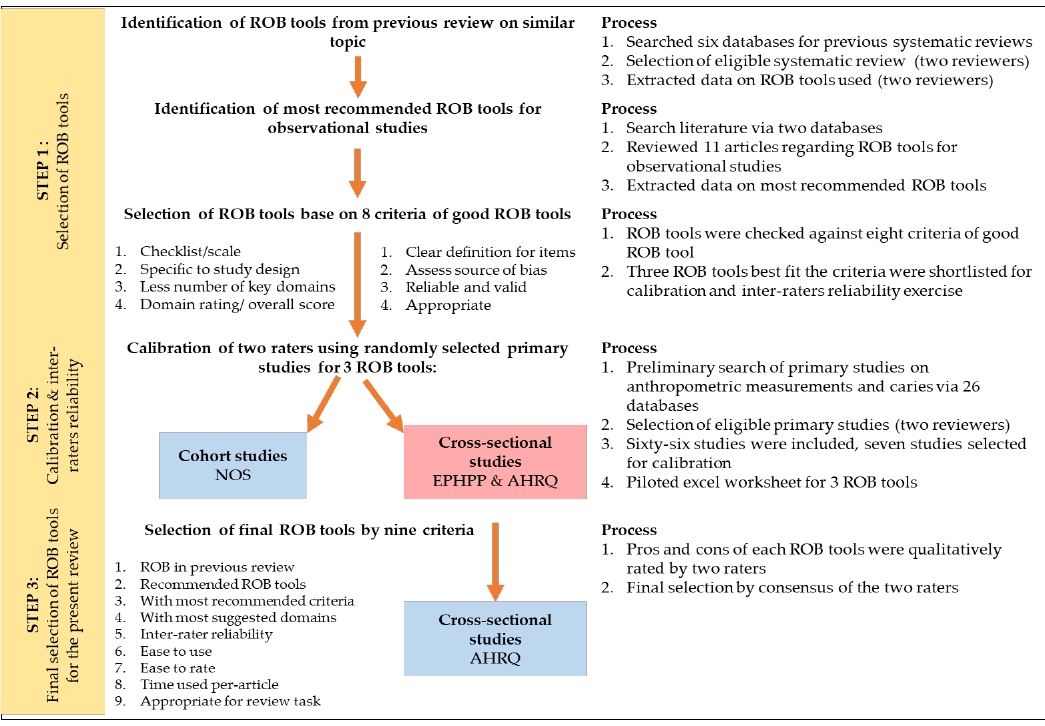
Figure 1. Process of selecting the most appropriate ROB tools for the present review.